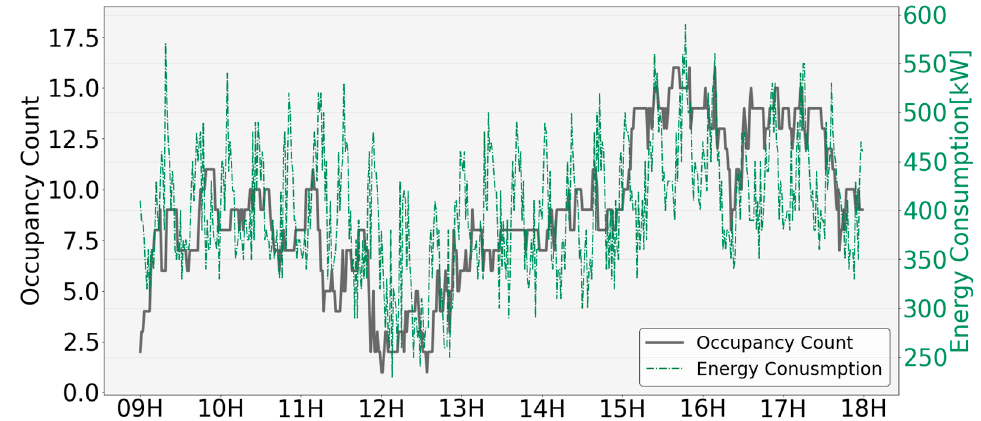
Figure 14. Analysis of occupancy and energy consumption pattern.